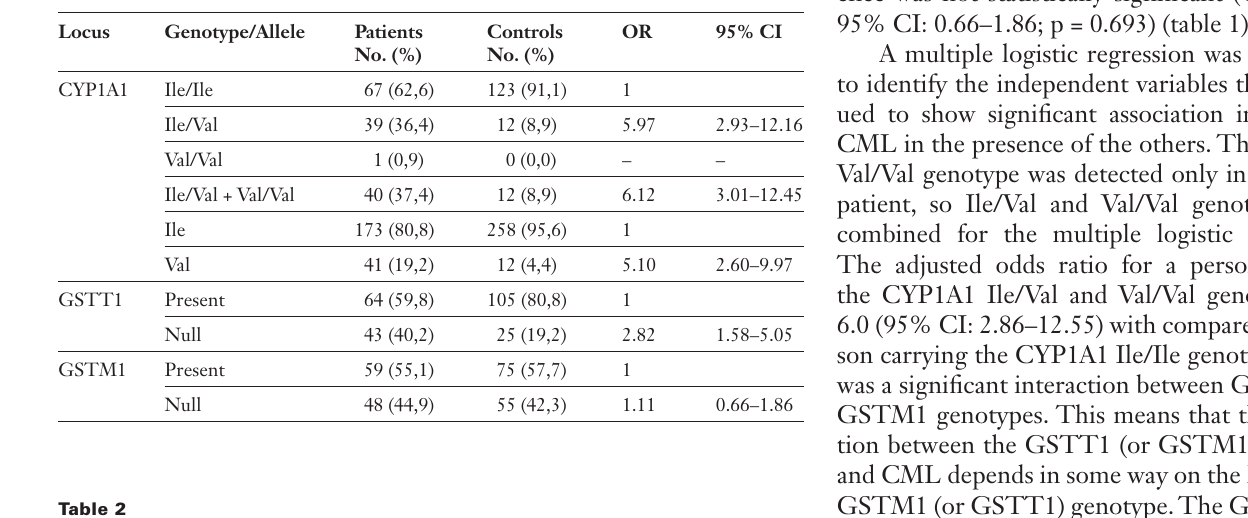
The distribution of the CYP1A1 Ile/Val, GSTT1 and GSTM1 genotypes in CML patients and controls.